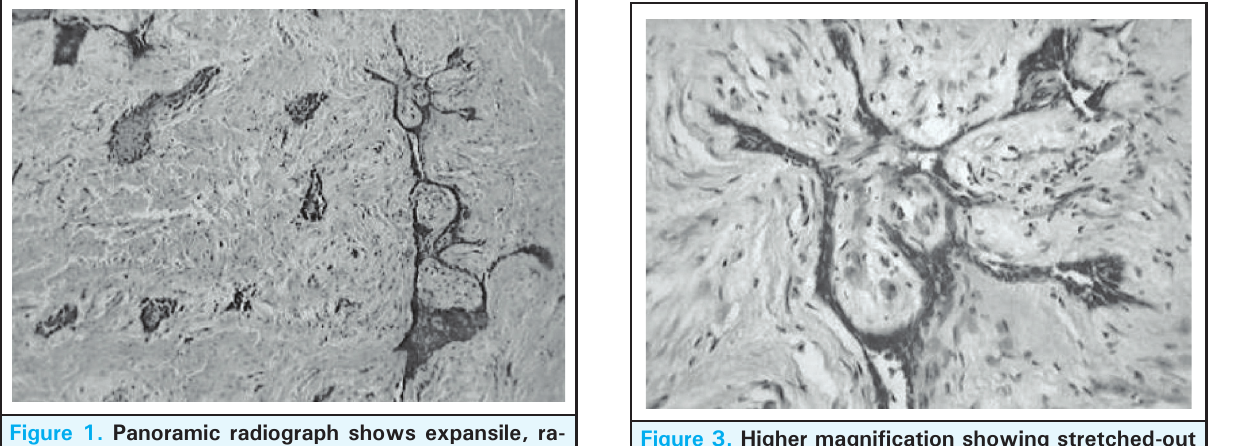
Figure 3. Higher magnification showing stretched-out odontogenic epithelial island in a dense desmoplastic stroma. (Hematoxylin-eosin stain,